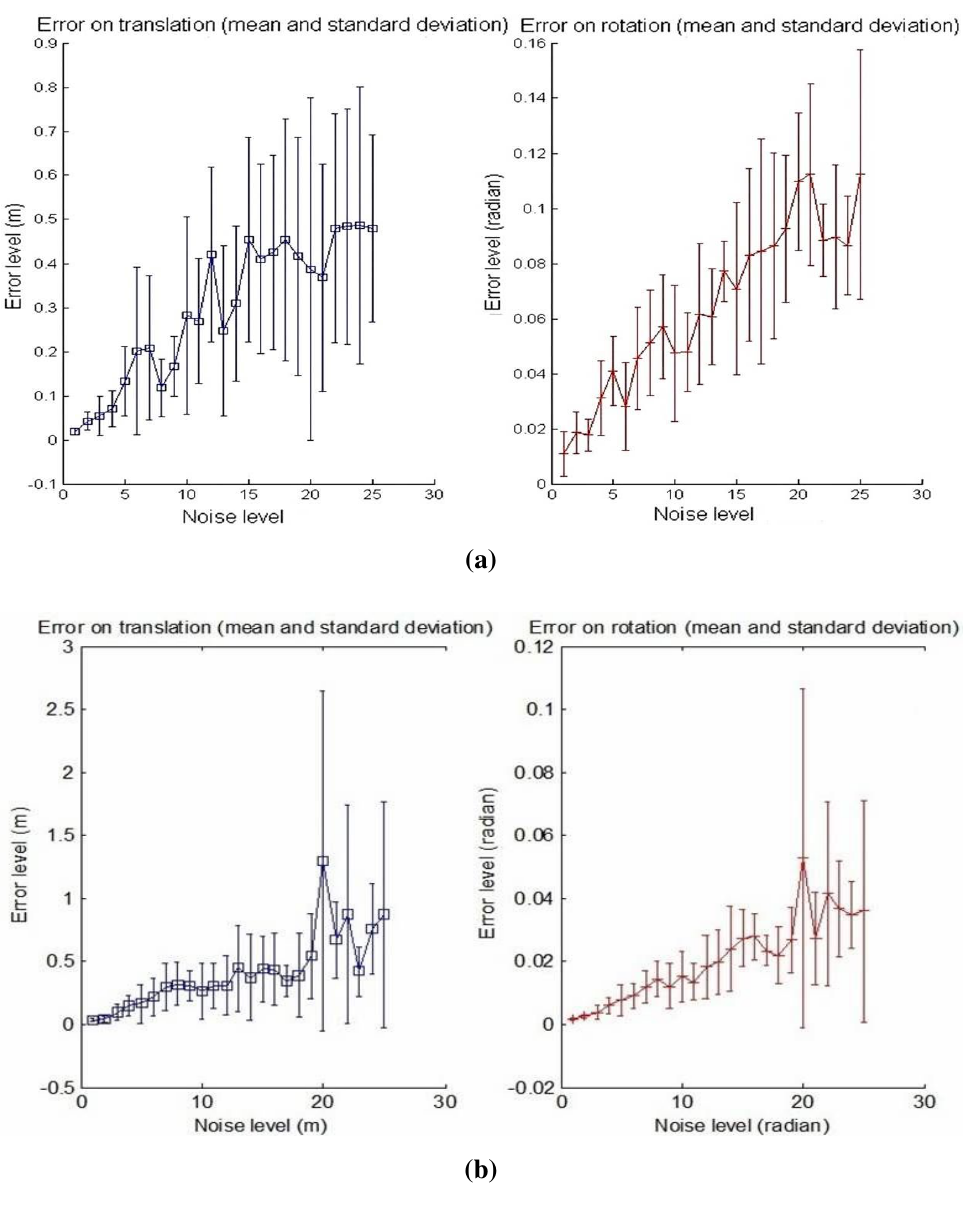
Figure 8. Calibration error with respect to the noise level. Left : translation error in meters; Right : rotation error in radians. The graphs show the mean and the standard deviation of RMSE upon six reiterations with 10 matches used. ( a ) First calibration method; ( b ) Second calibration